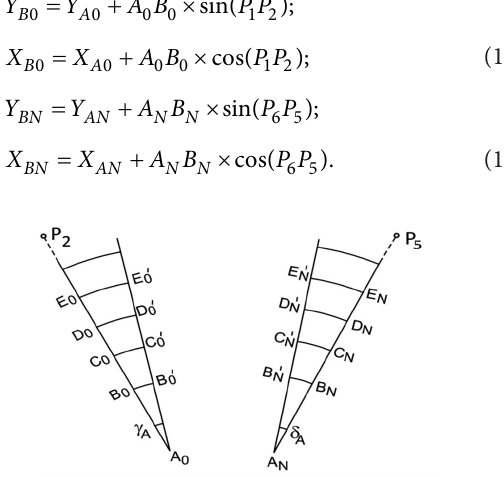
Figure 5. The intersection points (A 0 , B 0 , C 0 , ... K 0 ; A N , B N , C N , ... K N ) of the starting and finishing points with auditorium side walls (P 1 P 2 , P 6 P 5 ) until from second row to the end row (i.